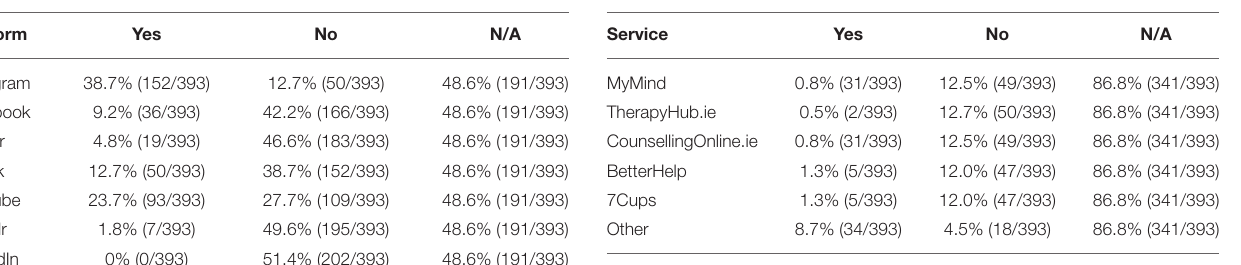
TABLE 5 | Use of professional services.